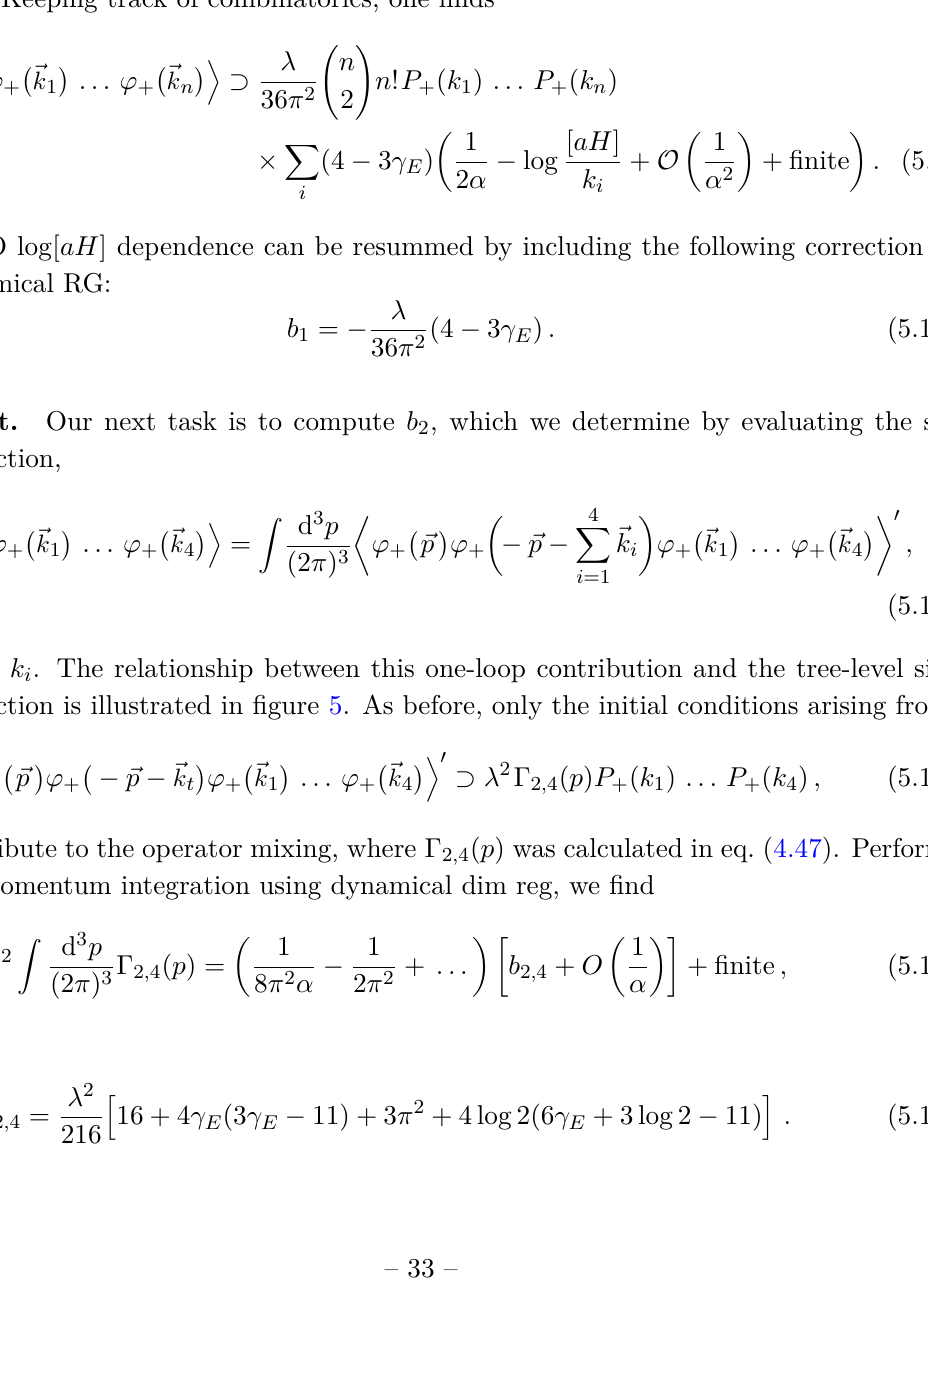
that looks like an anomalous dimension ( ϕ 2 +